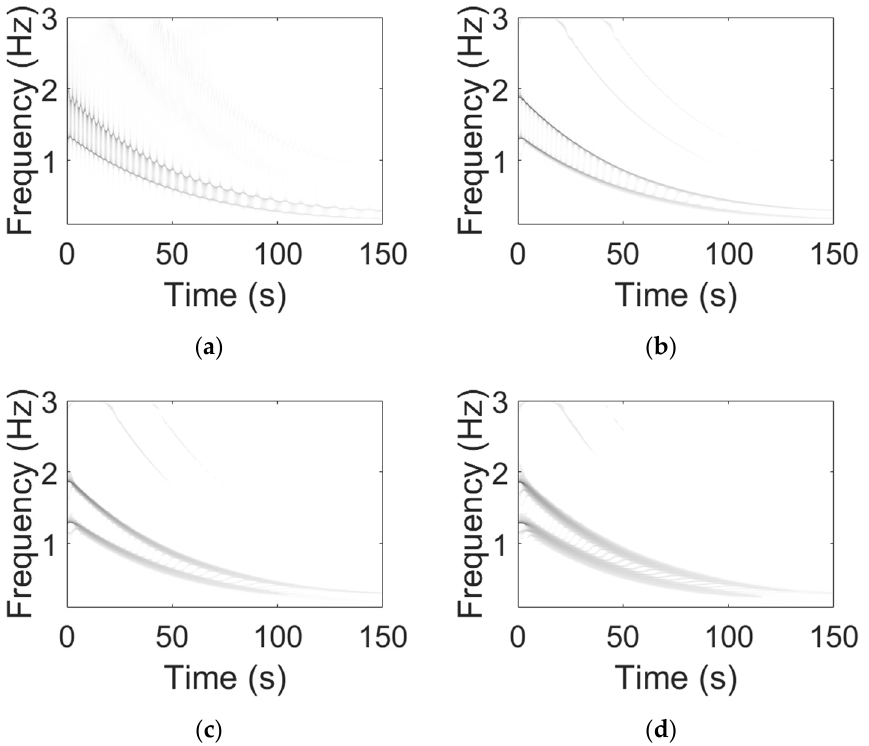
Figure 4. Synchro-squeezed wavelet transforms: ( a ) center frequency of 1 Hz; ( b ) center frequency of 2 Hz; ( c ) center frequency of 3 Hz; ( d ) center frequency of 4 Hz.